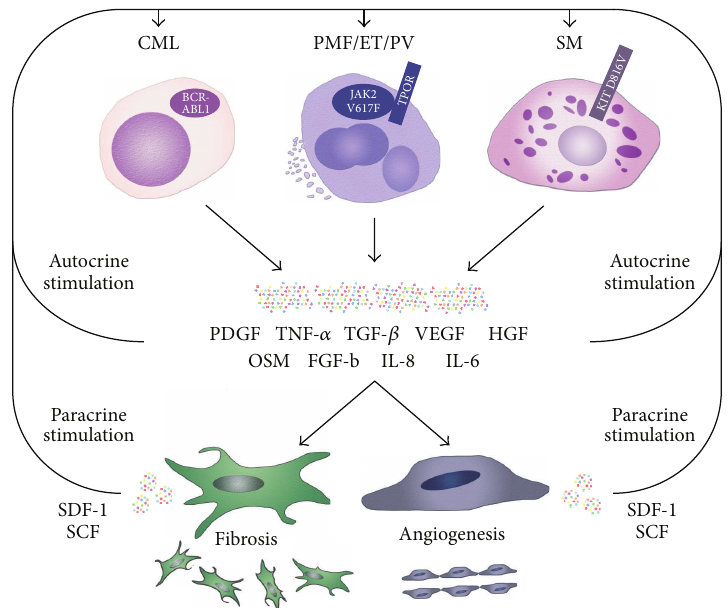
of neoplastic cells in myeloproliferative neoplasms. Neoplastic hematopoietic cells in chronic myeloid leukemia (CML), polycythemia vera (PV), essential thrombocythemia (ET), primary myelofibrosis (PMF), and systemic mastocytosis (SM) secrete various cytokines including fibroblast growth factor (FGF), hepatocyte growth factor (HGF), interleukin-6 (IL-6), IL-8, oncostatin M (OSM), platelet derived growth factor (PDGF), transforming growth factor- 𝛽 (TGF- 𝛽 ), tumor necrosis factor- 𝛼 (TNF- 𝛼 ), and vascular endothelial growth factor (VEGF). These cytokines bind to their receptors on the surface of fibroblast, endothelial cells, and other cells of the bone marrow stroma and induce fibrosis and angiogenesis. In turn, cytokine production in stromal cells (e.g., stroma derived factor-1, SDF-1, or stem cell factor, SCF) has been implicated in proliferation, migration, and clonal selection of hematopoietic cells as well as in resistance to